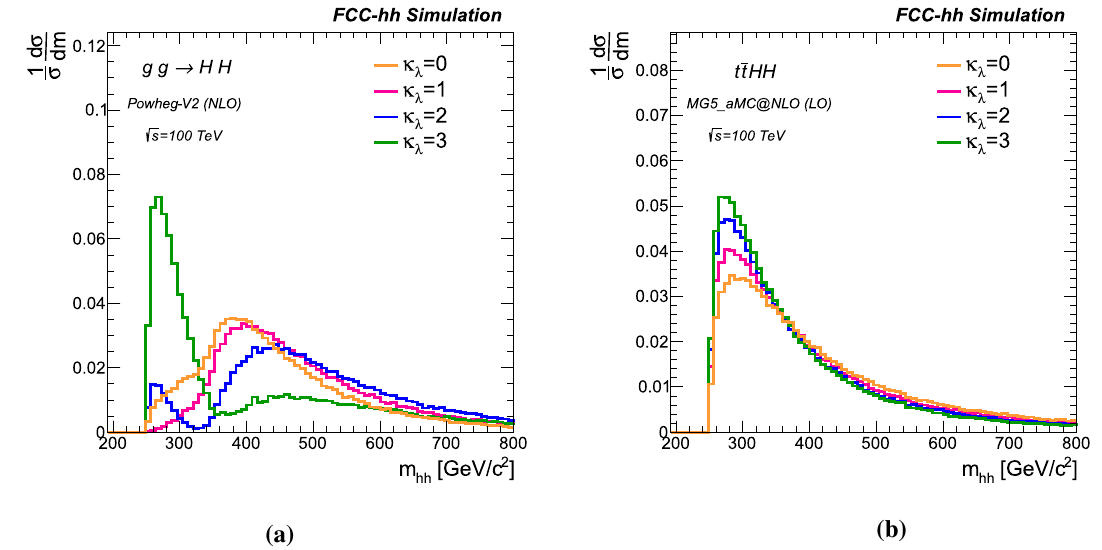
Fig. 3 Higgs pair invariant-mass distribution in ggHH ( a ) and t ¯ tHH ( b ) events for κ λ = 0, κ λ = 1, κ λ = 2 and κ λ = 3